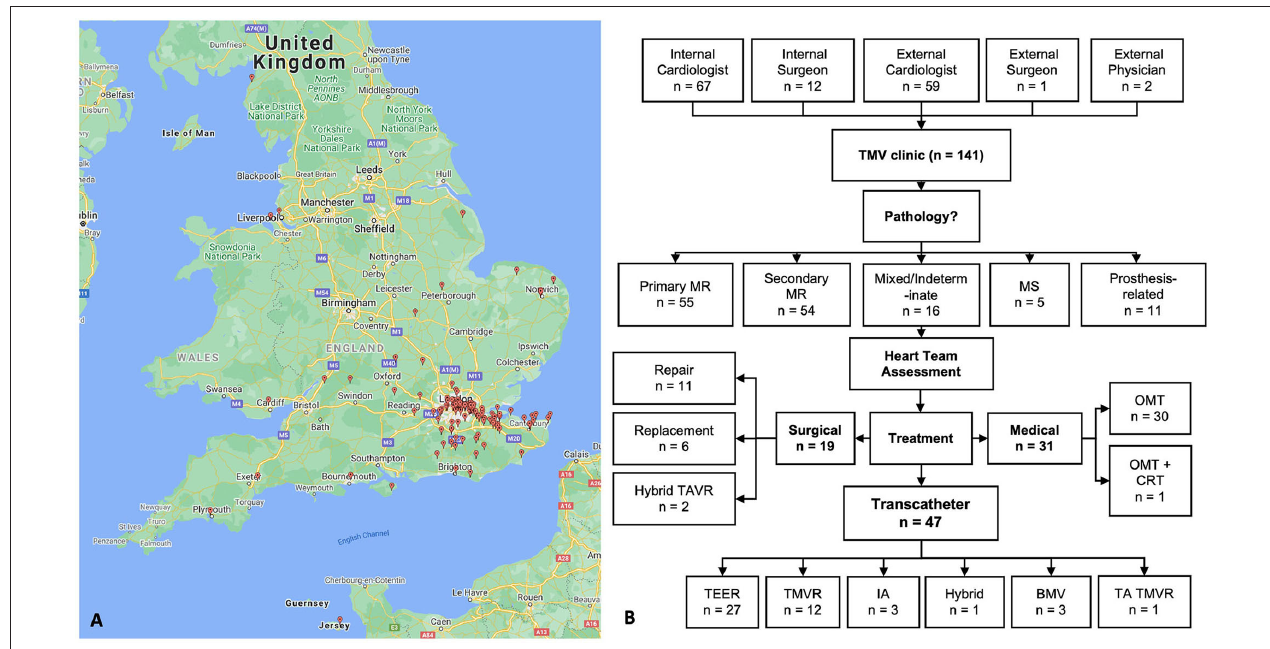
FIGURE 3 | (A) Geographical referral sources that developed upon establishment of the TMV service in London. (B) Overview of the pathway from referral to assessment and treatment. TMV, transcatheter mitral valve; MR, mitral regurgitation; MS, mitral stenosis; TAVR, transcatheter aortic valve replacement; OMT, optimum medical therapy; CRT, cardiac resynchronisation therapy; TEER, transcatheter edge-edge repair; TMVR, transcatheter mitral valve replacement; IA, indirect annuloplasty; BMV, balloon mitral valvuloplasty; TA TMVR, transapical transcatheter mitral valve.